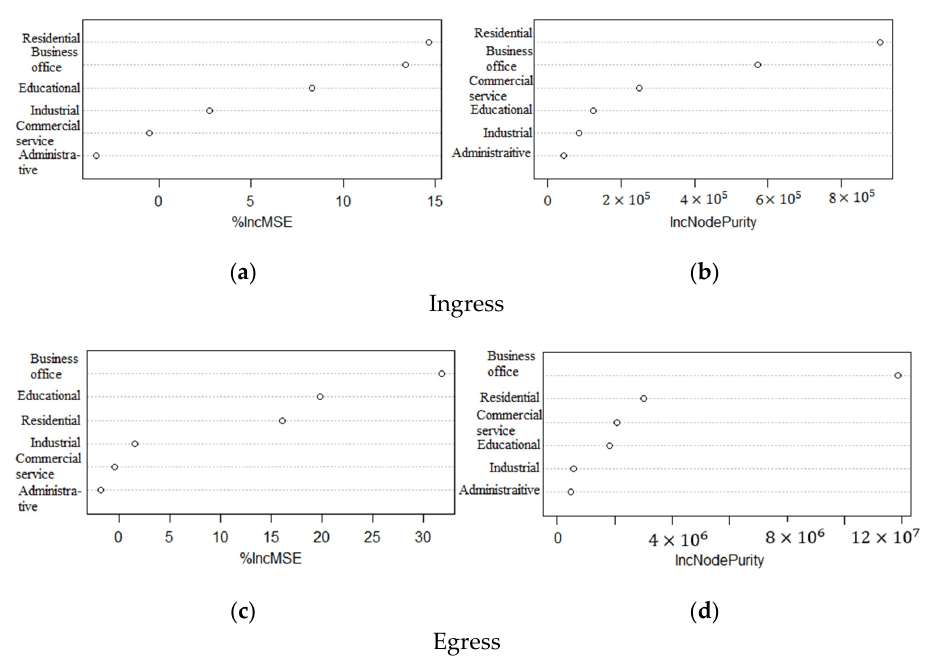
Figure 15. Variable importance plot for ingress and egress ridership: (a) mean squared error of Ingress (IncMSE) (b) residual sum of squares of Ingress (IncNodePurity) (c) mean squared error of Egress (IncMSE) (d) residual sum of squares of Egress (IncNodePurity) The variable importance plot (Figure 15) simply ranks the variable below a level of